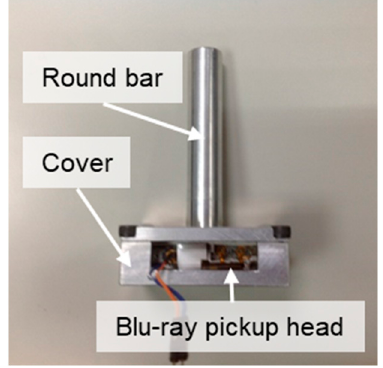
Figure 5. Fixture of Blu-ray pickup head (GBW-H10N).